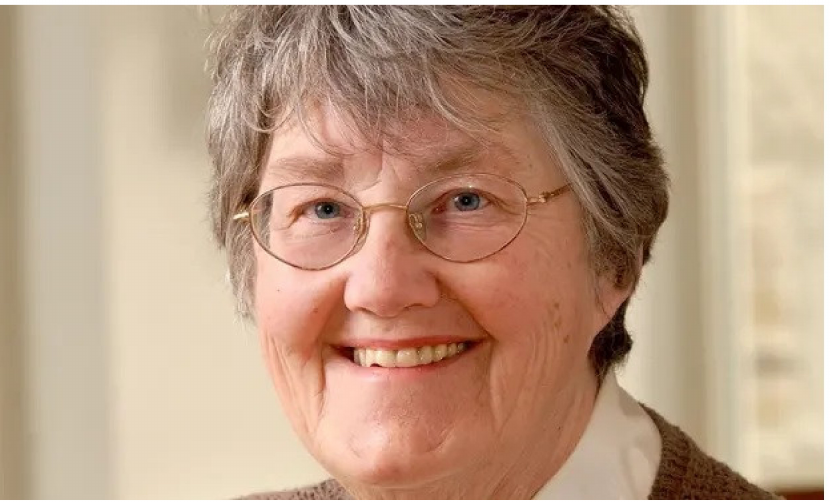
Figure 1. Rosemary Maguire MBE, the first Parkinson’s disease nurse specialist, who was appointed in the UK in 1989. Photo taken by Chris Saville, reprinted with permission from Mike Wilk at Apex News and